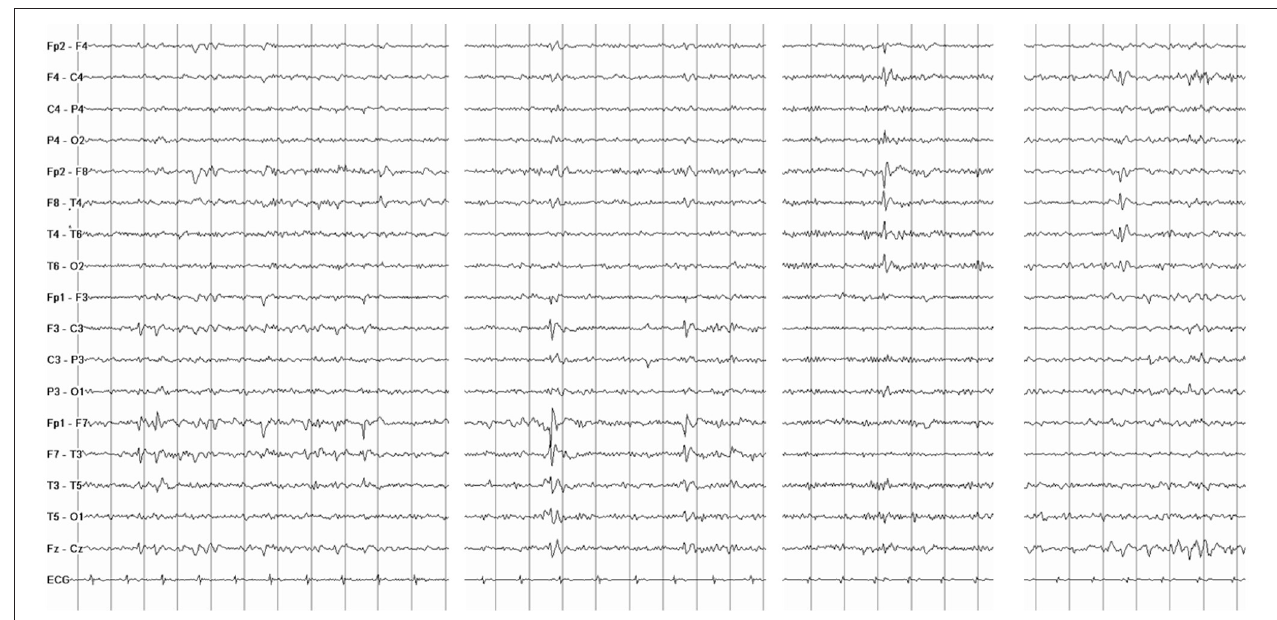
FIGURE 1 | Interictal electroencephalography (EEG) shows spiking activity and slow sharp waves located over the temporal regions